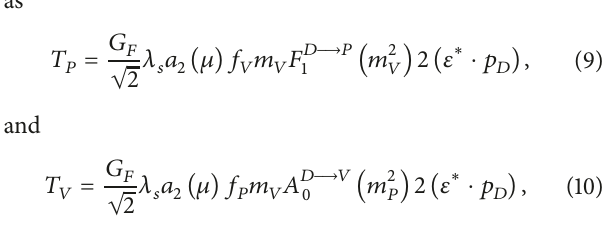
𝑃𝐸 𝑃(𝑉) , and (e) the gluon-exchange